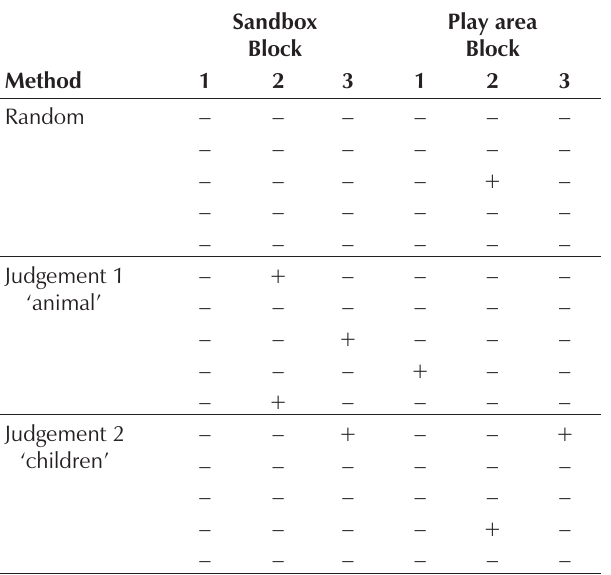
Figure 2) Spatial distribution of the presence of Toxocara species